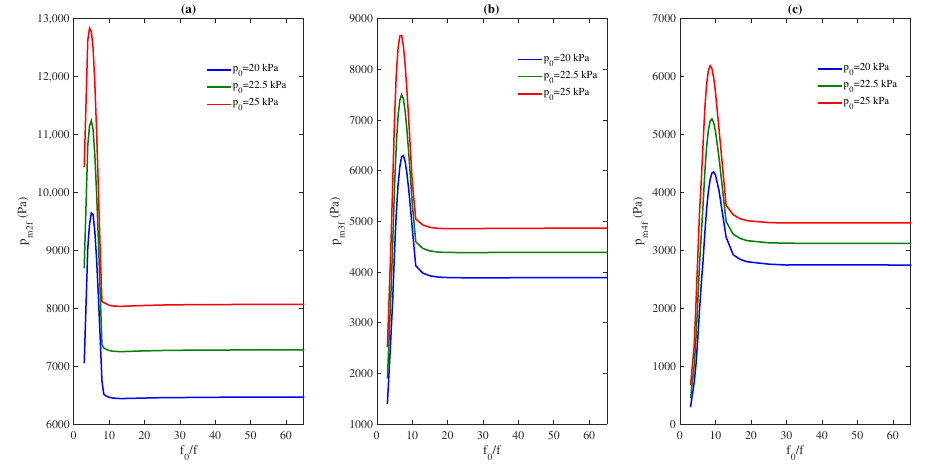
Figure 6. Maximum amplitude of 2 f ( a ), 3 f ( b ), and 4 f ( c ) in the cavity of length L = 16 λ vs. f 0 / f , for three different source amplitudes p s = 20 kPa (blue line), p s = 22.5 kPa (green line), and p s = 25 kPa (red